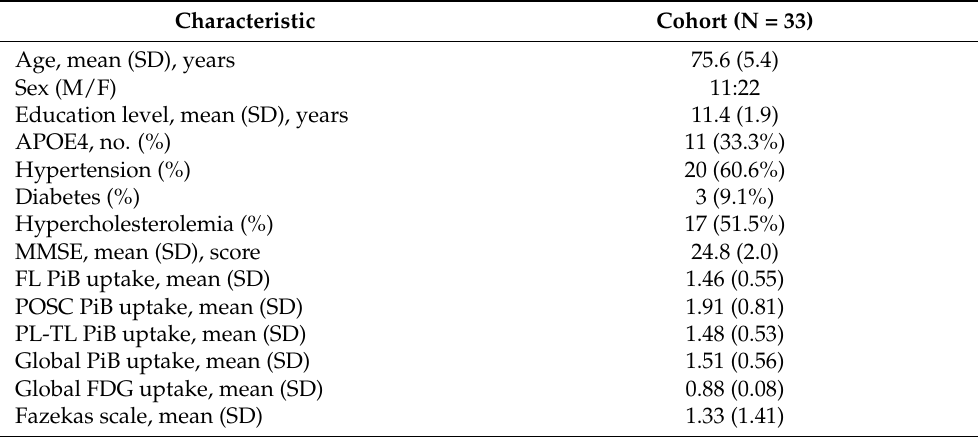
Table 1. Clinical and demographic